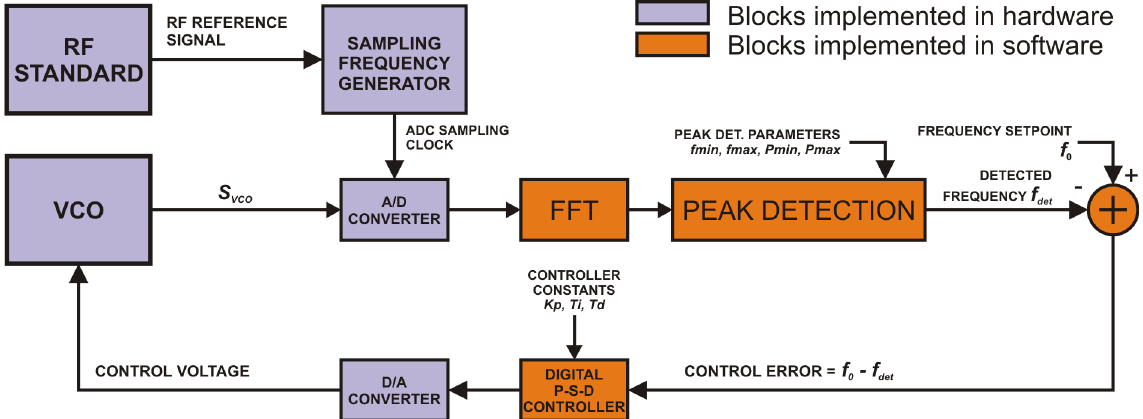
Figure 3. The block schematics of the frequency-locked loop based on